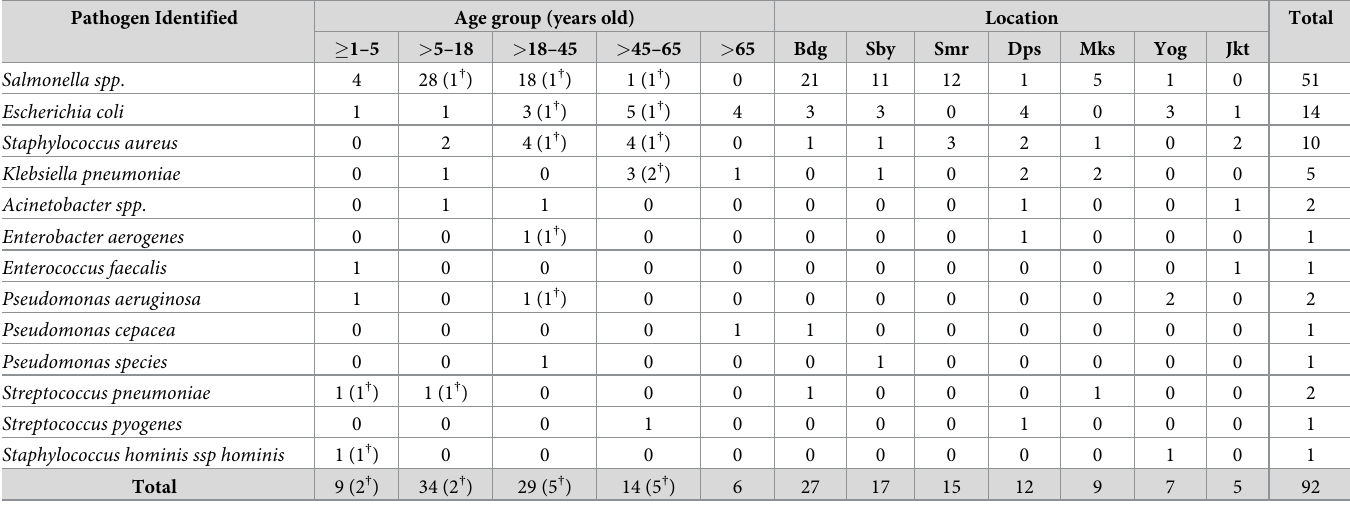
Table 3. Positive blood culture pathogens by participant age group and study